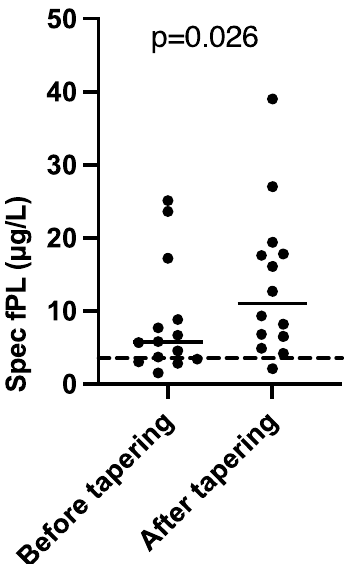
Figure 2. Comparison of serum Spec fPL concentrations before tapering/withdrawal and at follow- up in 14/19 cats with presumed chronic pancreatitis treated with cyclosporine. Short horizontal lines represent median, long horizontal stippled line represents upper limit of the reference interval (3.5 μ g/L).